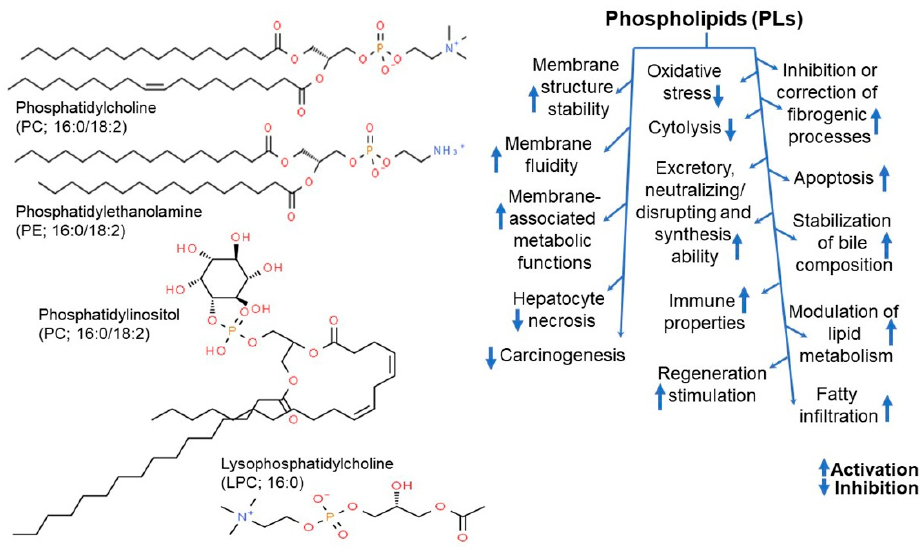
Figure 14. Structure of the major phospholipids (PLs) found in soybean lecithin ( left panel ) and action mode of PLs in liver diseases ( right panel) [154].